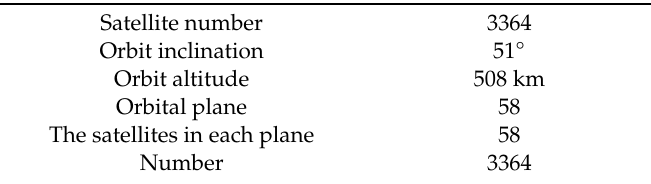
Figure 5. The acquisition probabilities of an integrated signal and a BOC signal. The clock cycle required for one acquisition process is shown in Table 2. Since the sampling frequency